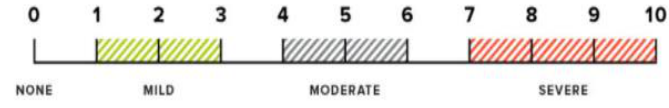
Figure 1. How do you feel the pain will be during